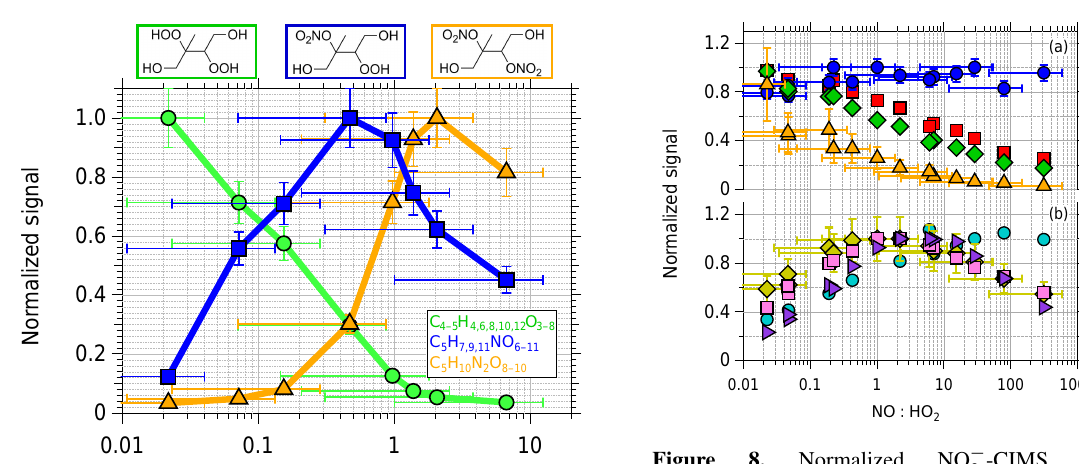
Figure 8. Normalized NO − -CIMS signals of (a) 3 C 5 H 6 , 8 O 5 − 7 , C 6 − 9 H 8 , 10 , 12 , 14 O 6 − 12 , C 10 H 14 , 16 , 18 O 5 − 14 , and C 19 − 20 H 28 , 30 , 32 O 9 − 18 , and (b) C 5 H 7 NO 6 − 11 , Figure 7. Normalized NO − -CIMS signals of C 5 H 6 , 8 , 10 , 12 O 3 − 8 , C 6 − 9 H 9 , 11 , 13 , 15 NO 5 − 10 , C 10 H 15 , 17 NO 4 − 14 , and 3 C 5 H 7 , 9 , 11 NO 6 − 11 , and C 5 H 10 N 2 O 8 − 10 isoprene ox- C 10 H 16 , 18 N 2 O 6 − 13 α -pinene oxidation products generated in the idation products generated in the PAM reactor at PAM reactor at I 254 = 1.8 × 10 15 phcm − 2 s − 1 , [H 2 O] = 0.07%, I 254 = 2.1 × 10 15 phcm − 2 s − 1 , [H 2 O] = 1%, [O 3 ] = 5ppm, and [O 3 ] = 5ppm, and mean residence time = 80s as a function of mean residence time = 80s as a function of modeled NO:HO 2 . modeled NO:HO 2 . For each of the species classes, signals were For each of the species classes, signals were normalized to the normalized to the maximum signal. Representative error bars maximum signal. Proposed structures for C 5 H 12 O 6 , C 5 H 11 NO 7 , indicate ± 1 σ uncertainty in NO − -CIMS signals and ± 85% 3 and C 5 H 10 N 2 O 8 signals are shown as representative compounds uncertainty in modeled NO:HO 2 . for each species class (Fig. 5). Representative error bars indicate ± 1 σ uncertainty in NO − -CIMS signals and ± 85% uncertainty in 3 NO:HO 2 . actions if their yields are not oxidant-dependent. If this were the case, C 10 H 16 , 18 N 2 O 6 − 13 : C 10 H 15 , 17 NO 4 − 14 should